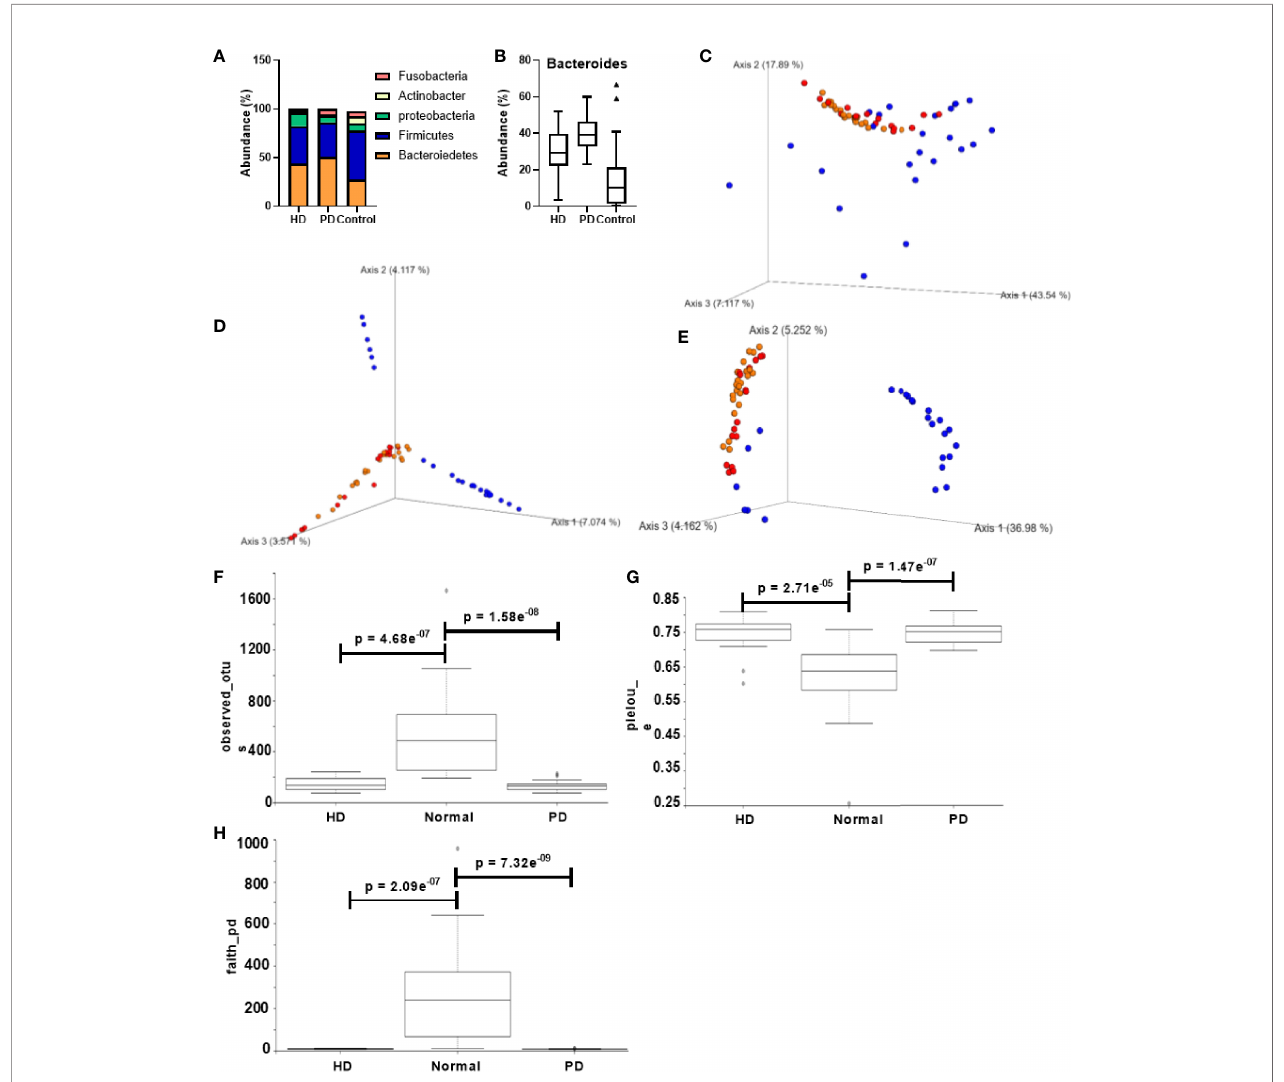
FIGURE 2 | Comparison of gut microbiota composition in CKD patients and healthy control groups. (A) Taxonomic abundance at the phylum level for HD, PD, and normal groups. (B) Bacteroides abundance percentage compared across different groups. PCoA of the beta diversity values based on (C) weighted UniFrac, (D) Bray – Curtis, and (E) unweighted UniFrac. Yellow = PD, red = HD, blue = normal. Alpha diversity analysis HD, PD, and normal groups based on (F) observed_otus, (G) pielou_e, and (H) faith_pd. Y-axis: alpha diversity indices in the respective